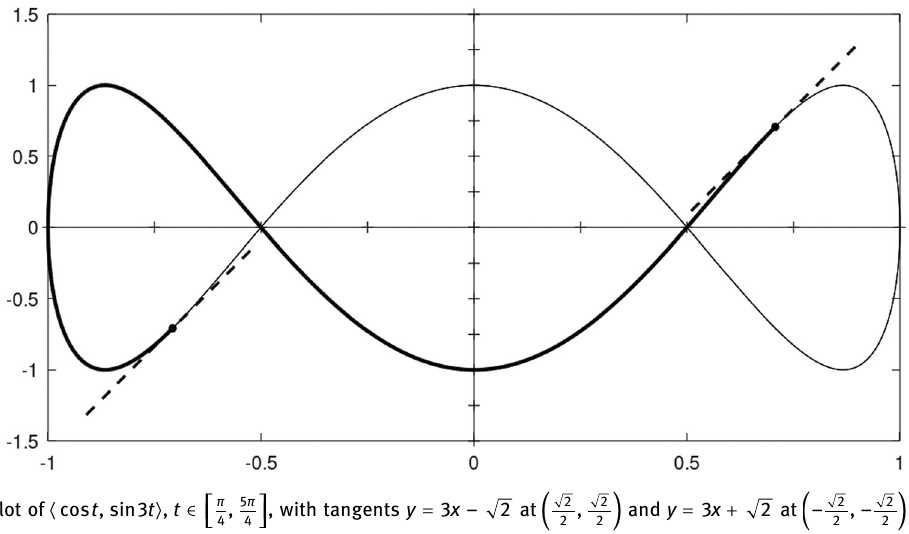
Figure 1: Plot of ⟨